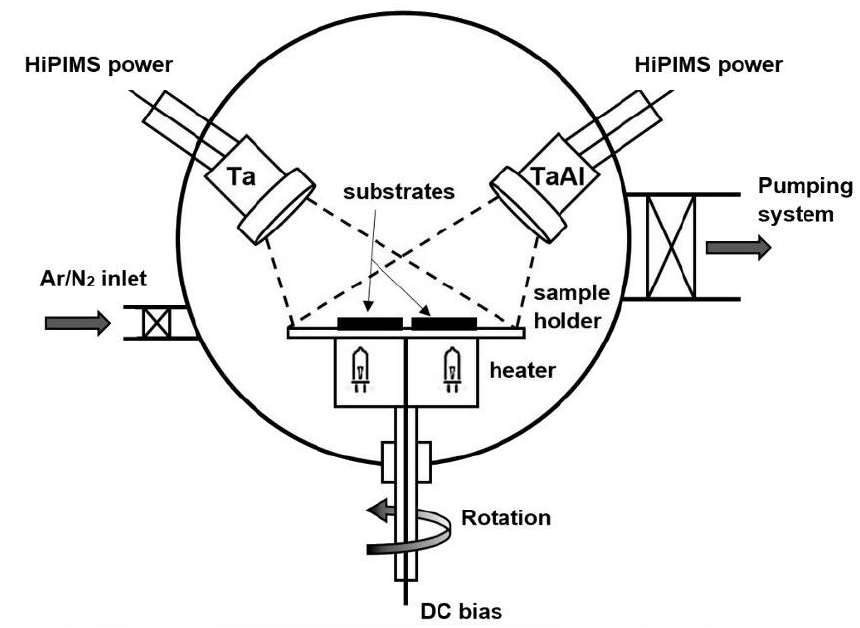
Figure 1. Schematic of the deposition chamber setup. The target-to-substrate distance was fixed at 120 mm for all sputtering runs. The coatings were deposited using a True Plasma High Pulse 4002 power supply (TRUMPF Hüt- tinger, Freiburg, Germany). The average sputtering power density was set at 6.4 W/cm 2 , with a pulse frequency of 500 Hz and pulse length of 25 µ s. When using the tantalum source, the peak current density J pk was about 1.7 A/cm 2 and the peak voltage, V pk ~ 850 V for all depositions: J pk ~ 1.0 A/cm 2 and V pk ~ 930 V when sputtering the TaAl target. De- position durations were optimized in order to obtain films of comparable thicknesses. A negative direct current polarization was applied to the substrate using a 3018 HBP bias unit (TRUMPF Hüttinger, Freiburg, Germany). Different bias values were used to investigate their effects on the final properties (i.e., − 50 V, − 75 V, and − 100 V). To promote adhesion and mechanical support an inter-layer of Ta-Al alloy was firstly deposited under the same conditions on all the substrates. After film deposition, the samples were kept under